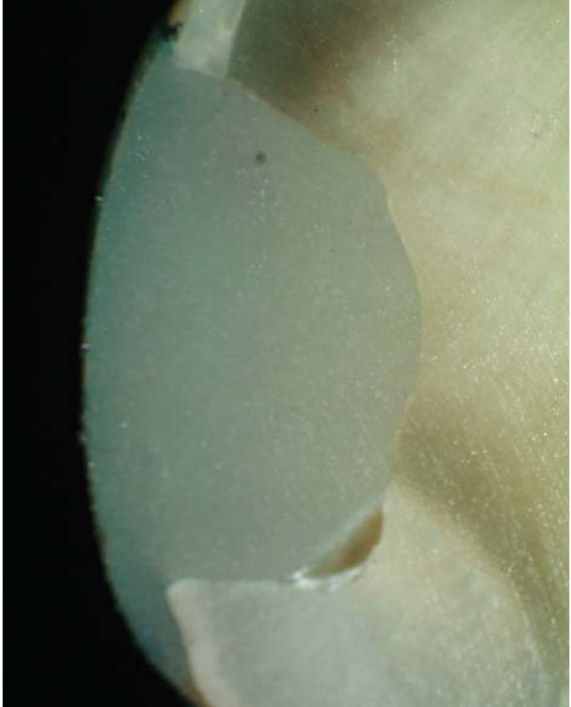
Figure 3- Photomicrograph of control group (bur) showing no micro leakage (score 0)